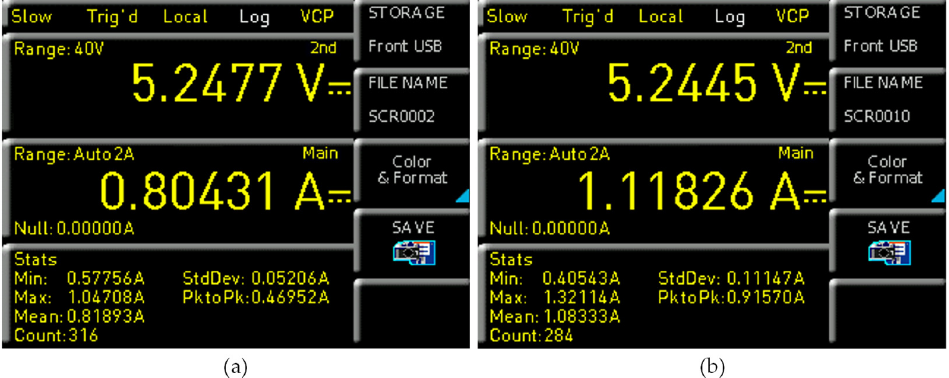
Figure 13. Electrical current consumption of standalone embedded system ( a ) Raspberry pi 3B; ( b ) Raspberry pi 4B.